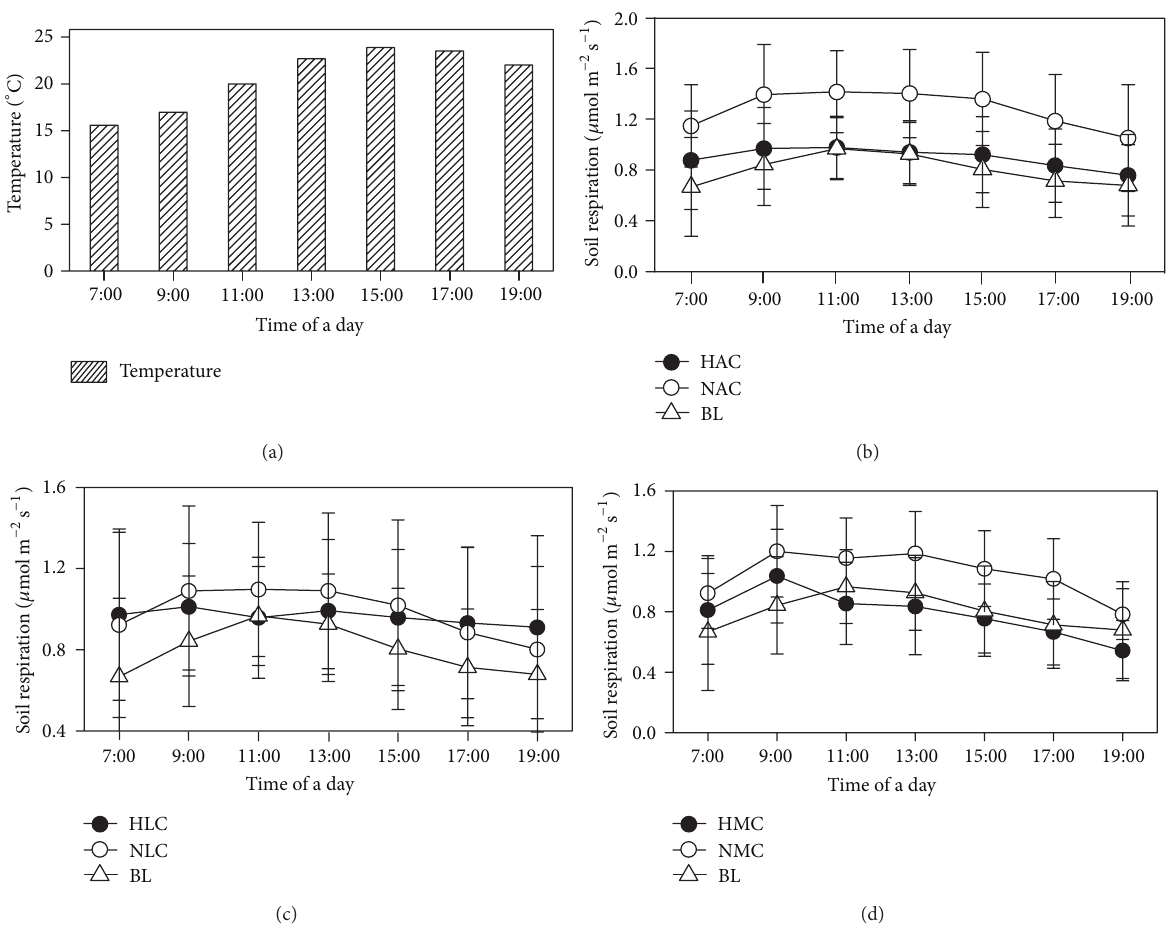
Figure 1: Diurnal variations in soil temperature (2cm depth, bars a) and Rs in biocrusted soil (black solid circle), disturbed biocrusted soil (hollow circle), and bare land (upward triangle) in algae crusted soil (b), lichen crusted soil (c), and moss crusted soil (d). Error bars indicate standard